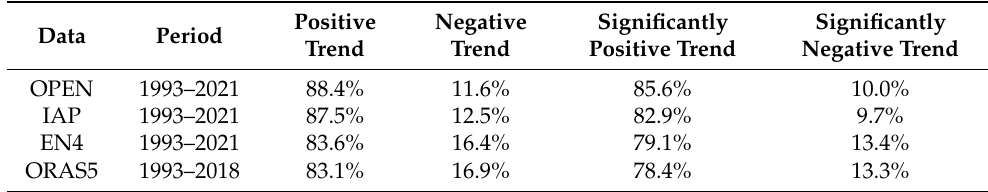
Table 3. Area proportions of statistically significant positive and negative OHC trends in the five